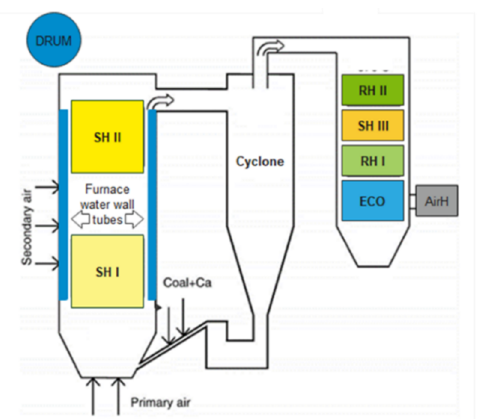
Figure 2. Schematic of a Circulating Fluidized Bed (CFB) boiler in steam power plant .